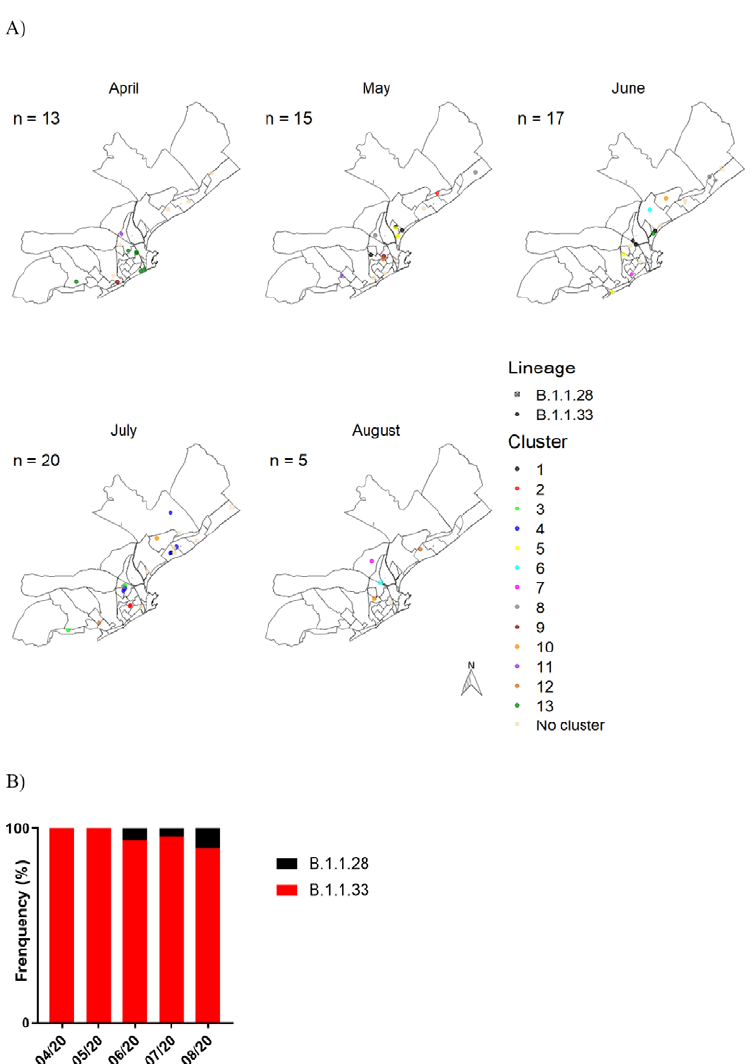
Figure 2. Spatiotemporal analysis of SARS ‐ CoV ‐ 2 variants in the urban area of Macaé over the first few months of the pandemic in 2020. ( A ) Map of the urban area of Macaé showing the spatial representation of SARS ‐ CoV ‐ 2 clusters and lineages over the first five months of the pandemic. ( B ) Histogram of the SARS ‐ CoV ‐ 2 lineages’ frequency over the first five months of the pandemic.